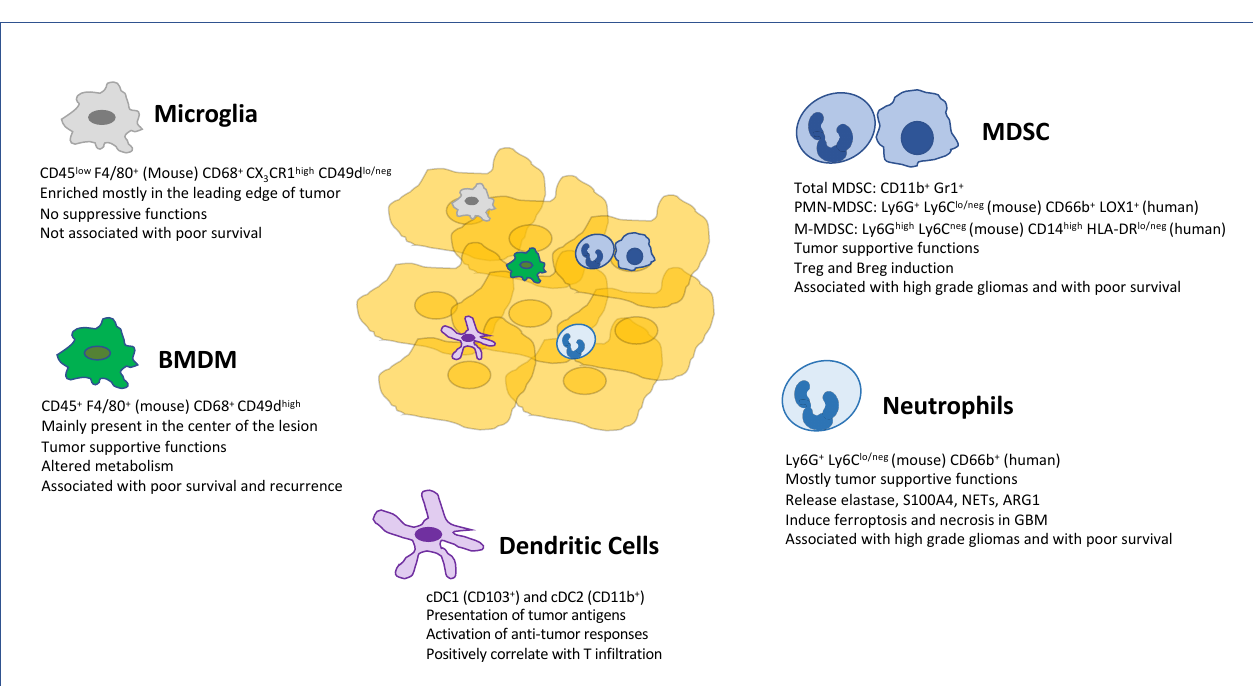
Figure 1. Myeloid cell compartment in the GBM tumor microenvironment. Surface molecules for the identification of myeloid cells are shown along with main characteristics and